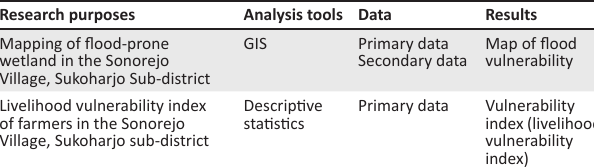
TABLE 1: Summary of research